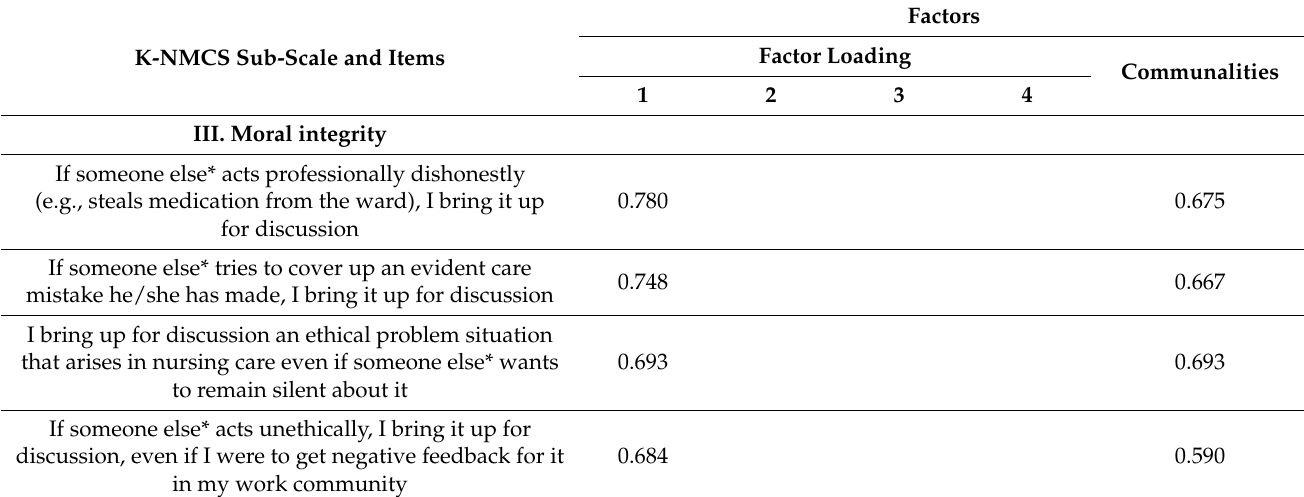
Table 1. Pattern matrix of factor loadings of the K-NMCS items from the factor analysis ( n =